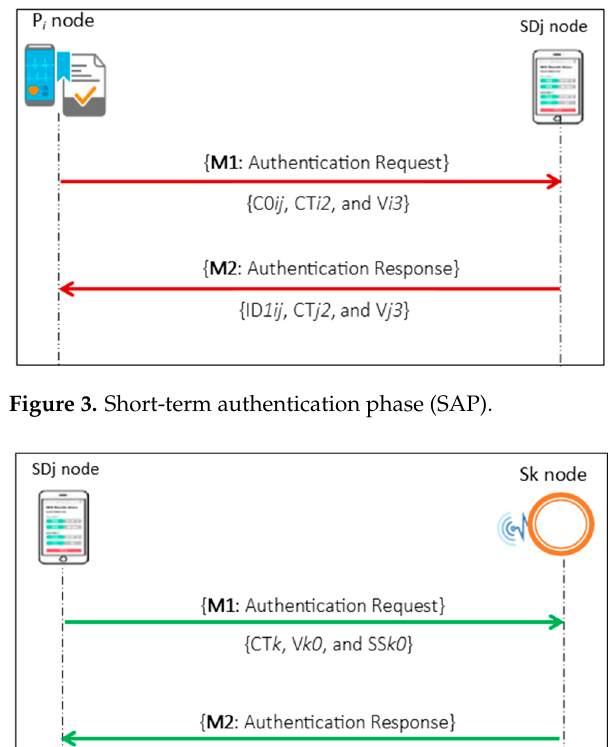
Figure 2. Long-term authentication phase (LAP).